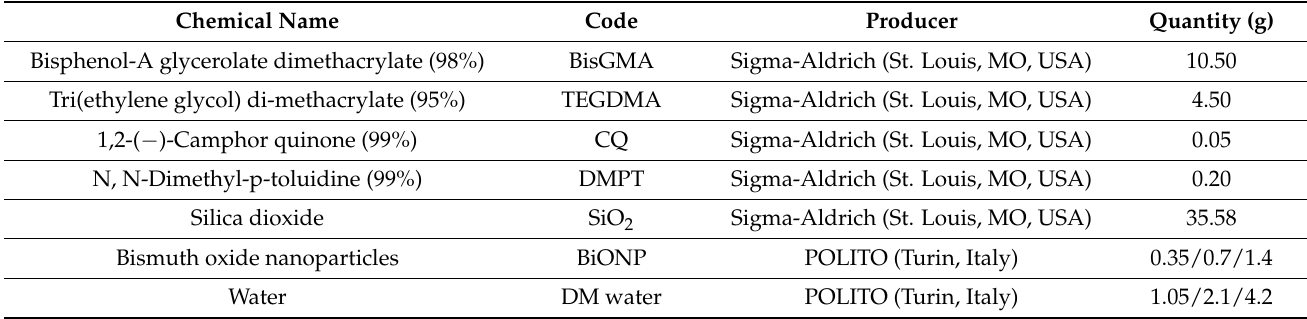
Table 2. Component details used for sample preparation.